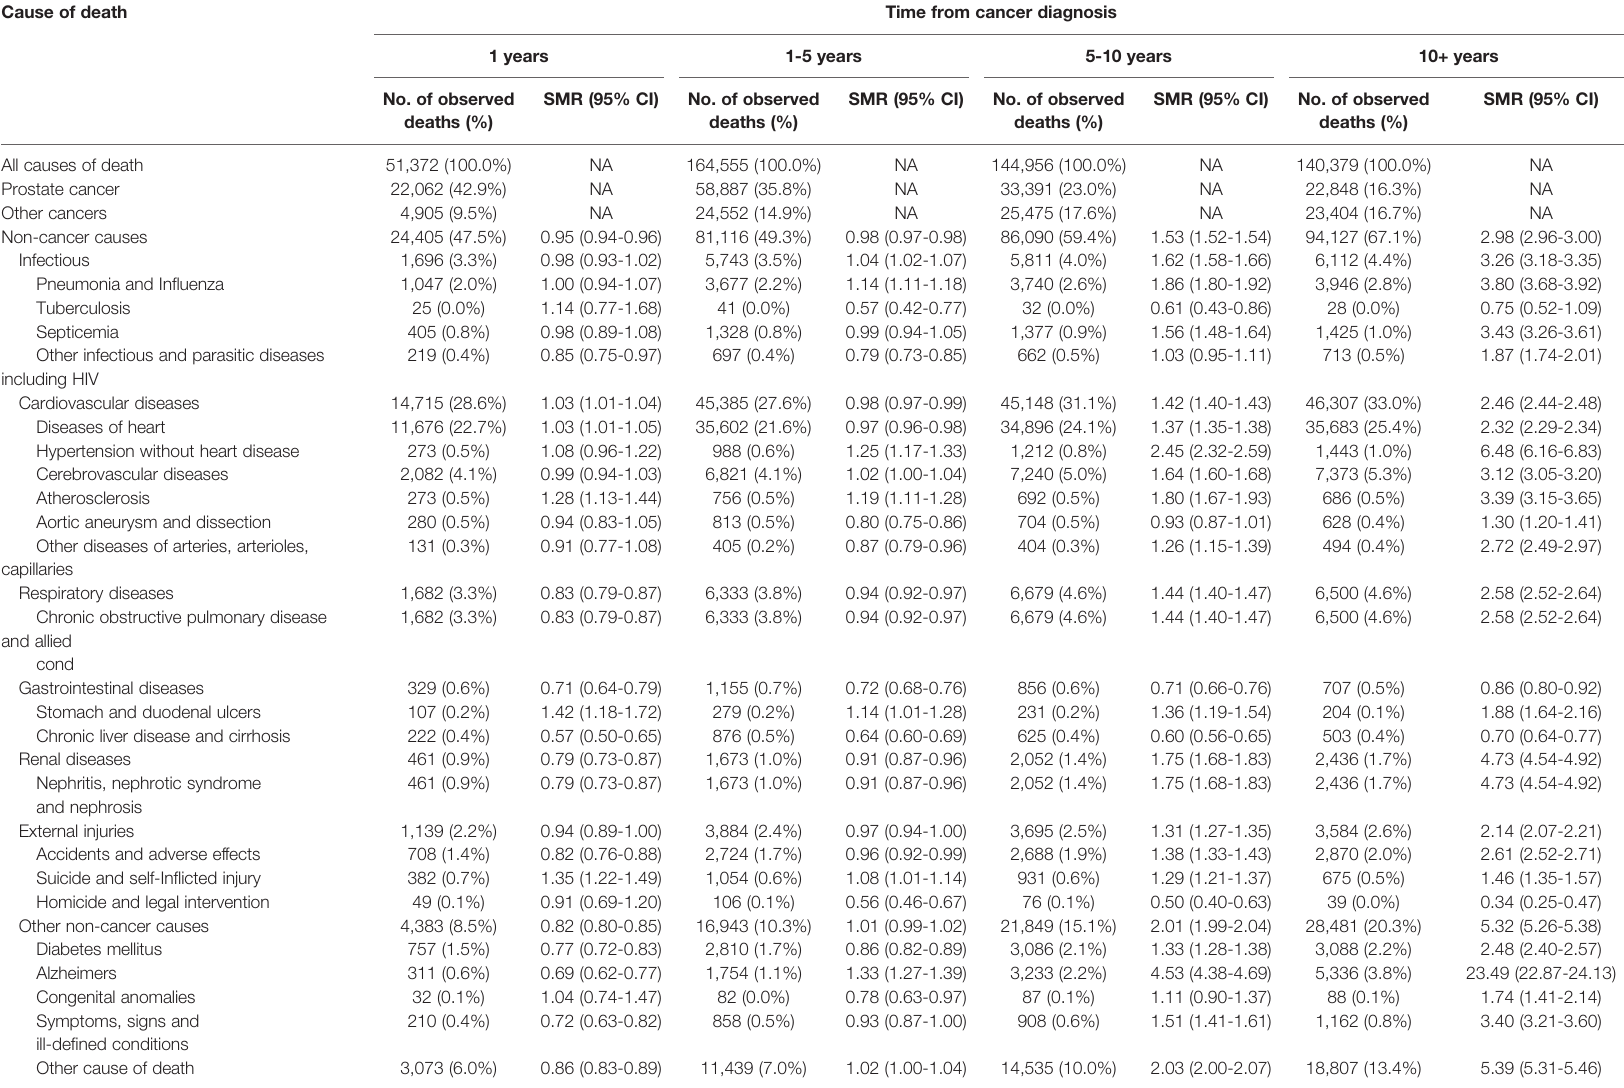
TABLE 3 | Cause of death among patients diagnosed with prostate cancer between 1975 and 2016 in SEER 18 registries by time from cancer diagnosis. Cause of